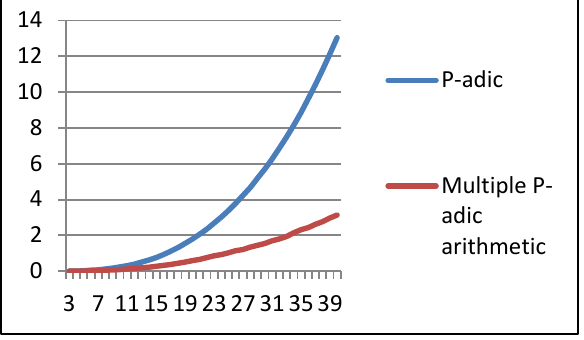
Fig. 7. Moore-Penrose Inverse vertical axis: the average implementation time in second horizontal axis: the matrix size